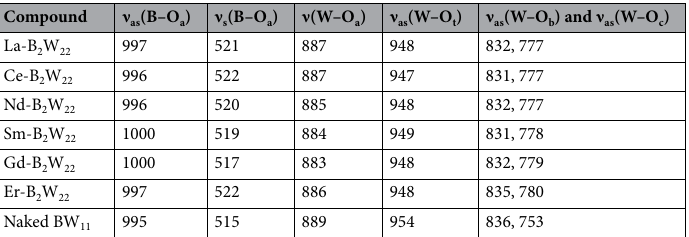
Table 1. Representation of important absorption bands (cm -1 ) for K 15 [Ln(BW 11 O 39 ) 2 ] (Ln = La, Ce, Nd, Sm, Gd, and Er) and naked [BW 11 O 39 ] 9− for comparison.